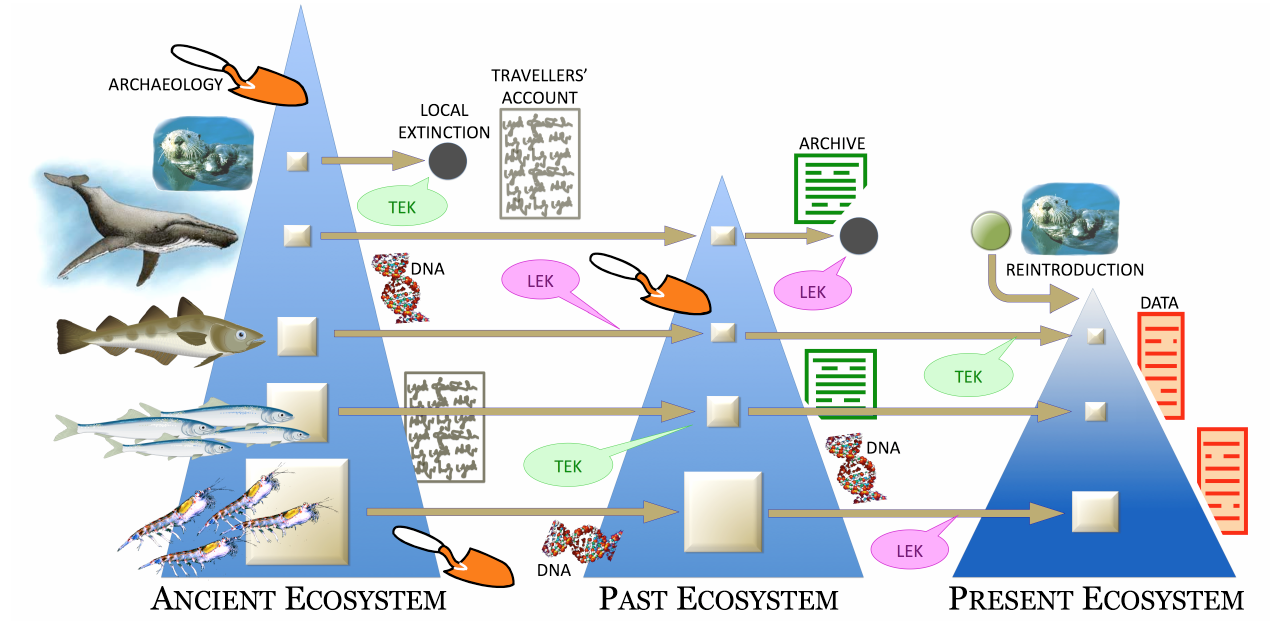
Fig. 1 . Holistic ecosystem models, such as mass-balance and agent-based frameworks, can provide approximate quantitative snapshots of historical ecosystems (triangles) and the biomass trajectories of organisms within them (boxes and arrows), based on archaeology, travellers’ accounts, archival records, traditional (TEK) and local (LEK) ecological knowledge, and scientific data, including rich information from DNA diversity